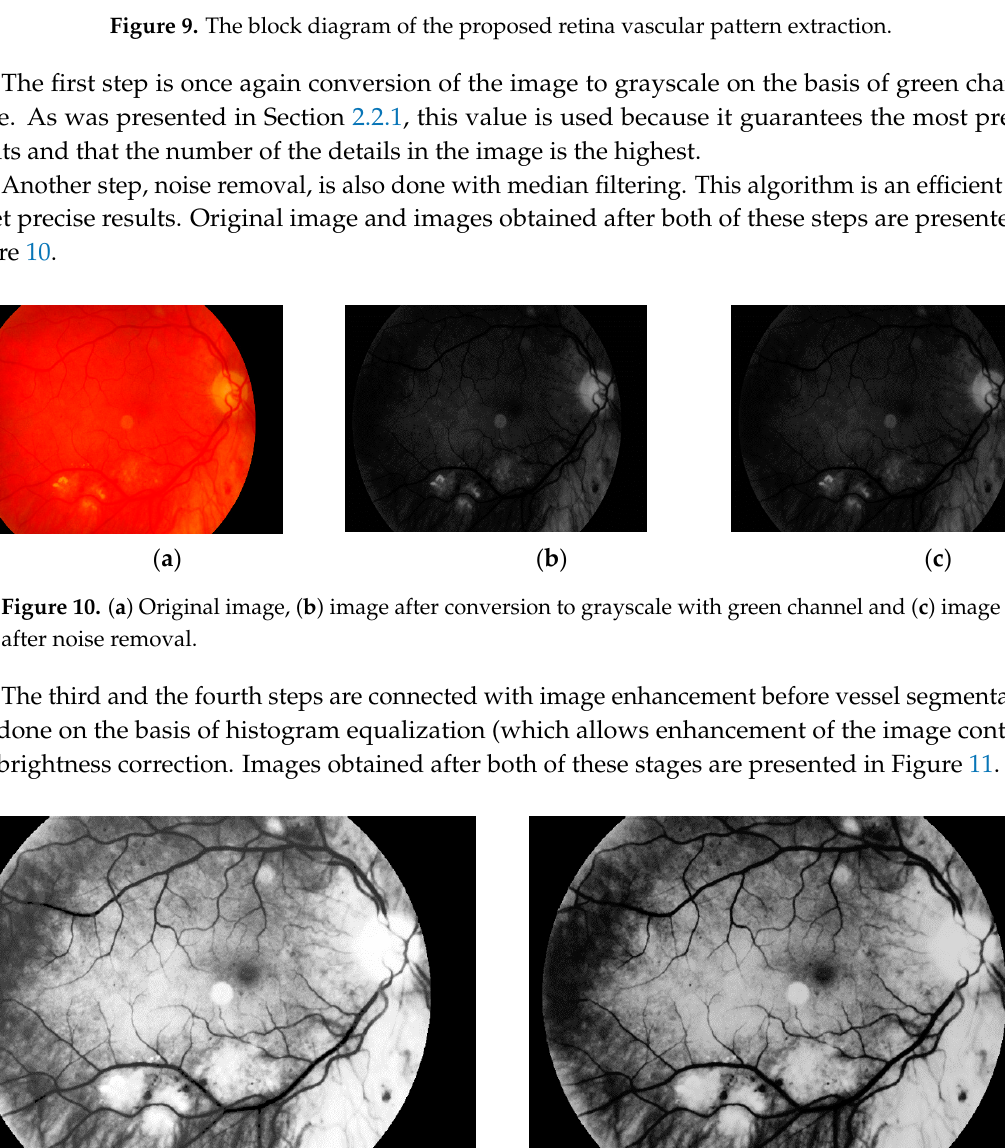
( b ) Figure 12. Image after ( a ) brightness correction and ( b ) Gaussian matched filter.